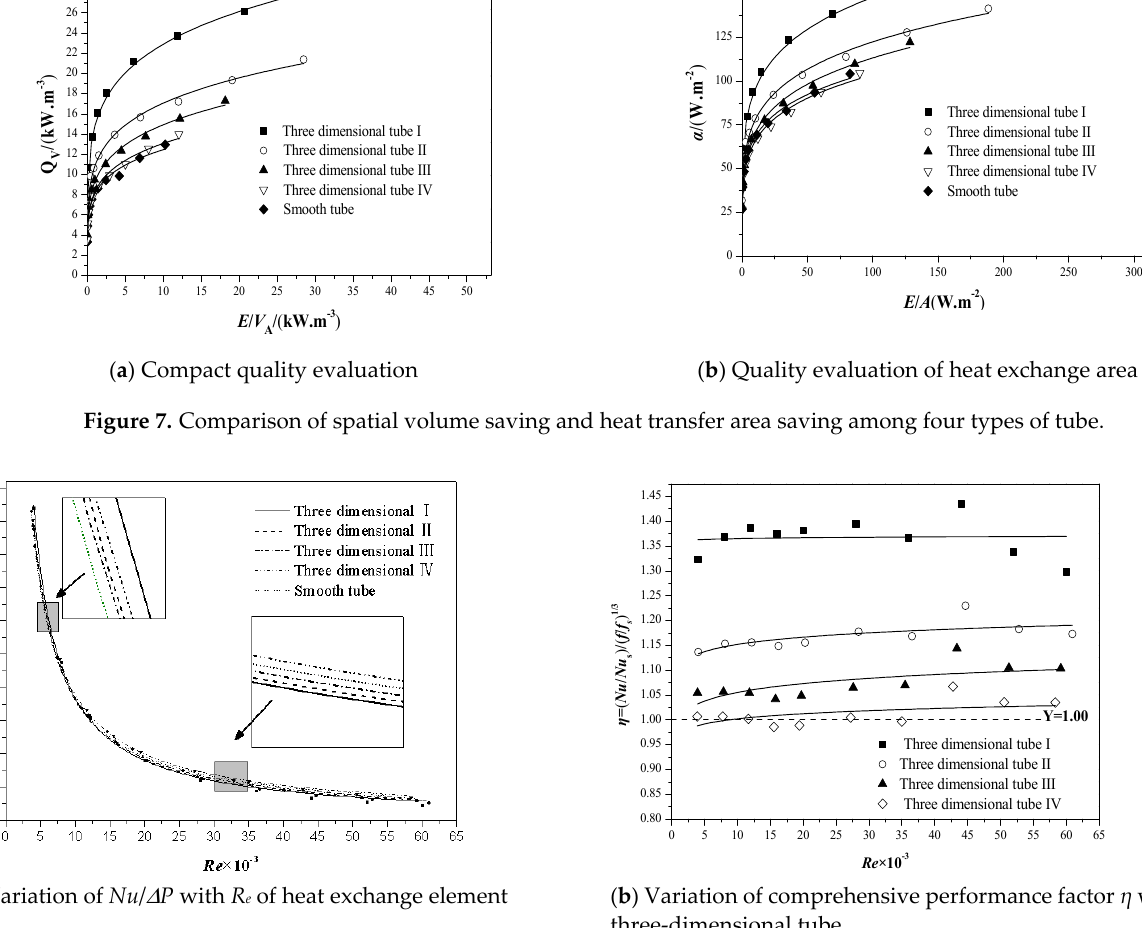
Figure 8. Curves of Nu / Δ P and η outside three-dimensional tube changing with Re .